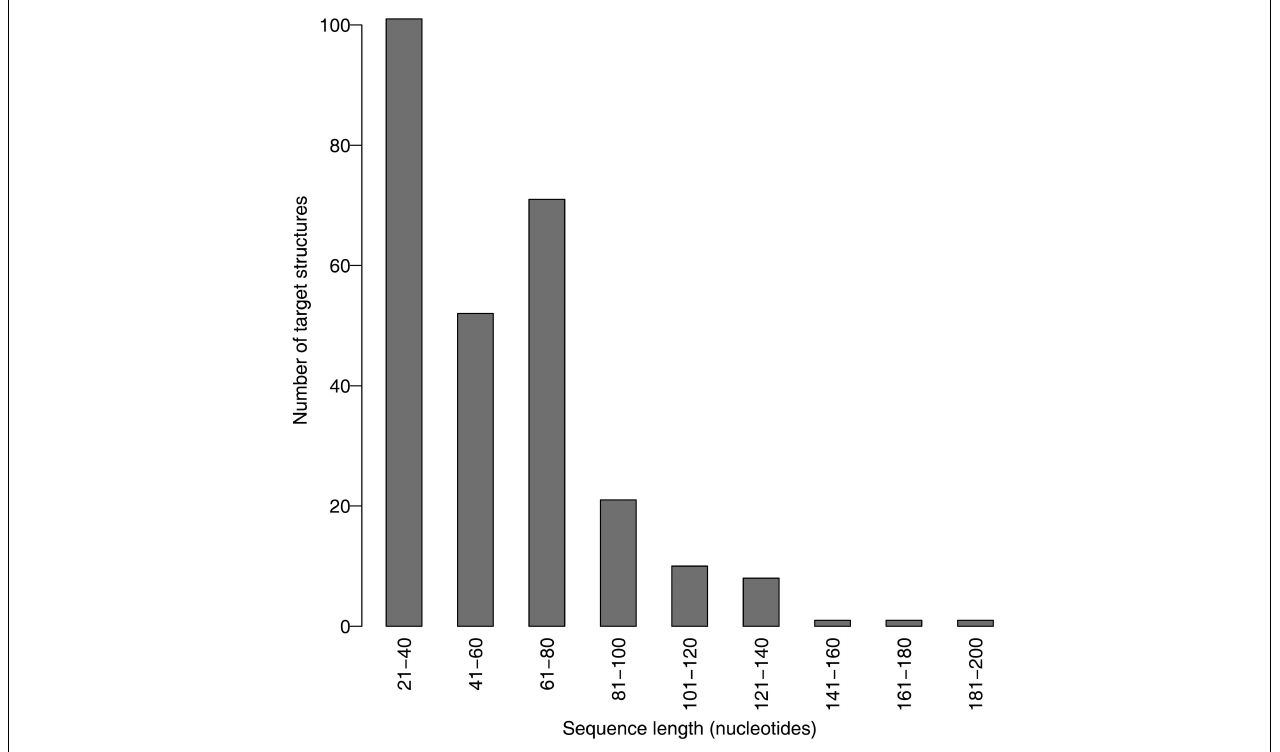
FIGURE 3 | Distribution of the target structures in the Pseudobase dataset.